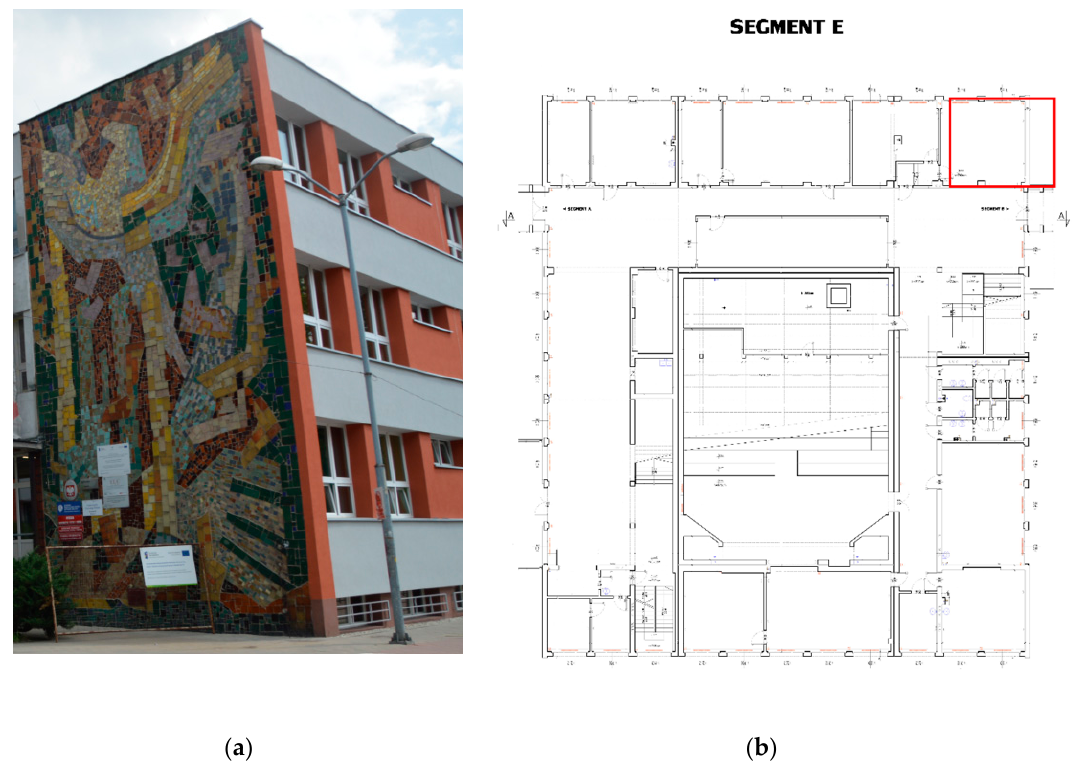
Figure 2. ( a ) Fragment of the building facade insulated partly from the outside and partly from the inside; ( b ) projection of a fragment of the building with the marked gable wall.